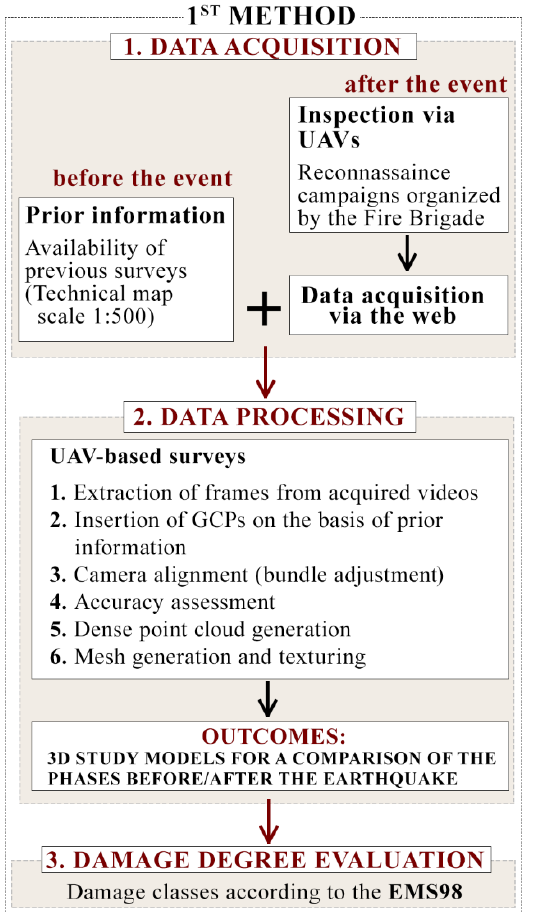
Figure 4. Workflow for DDE map for the 1 st method